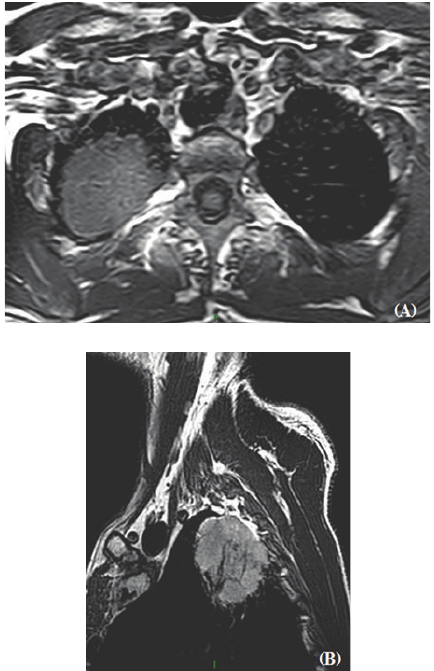
Figure 3: MR technique has a pivotal role in the assessment of the integrity of superior sulcus. The higher soft tissue resolution and the possibility to directly obtain images on axial (A) and sagittal (B) planes may help define the boundaries of an apical neoplasm.